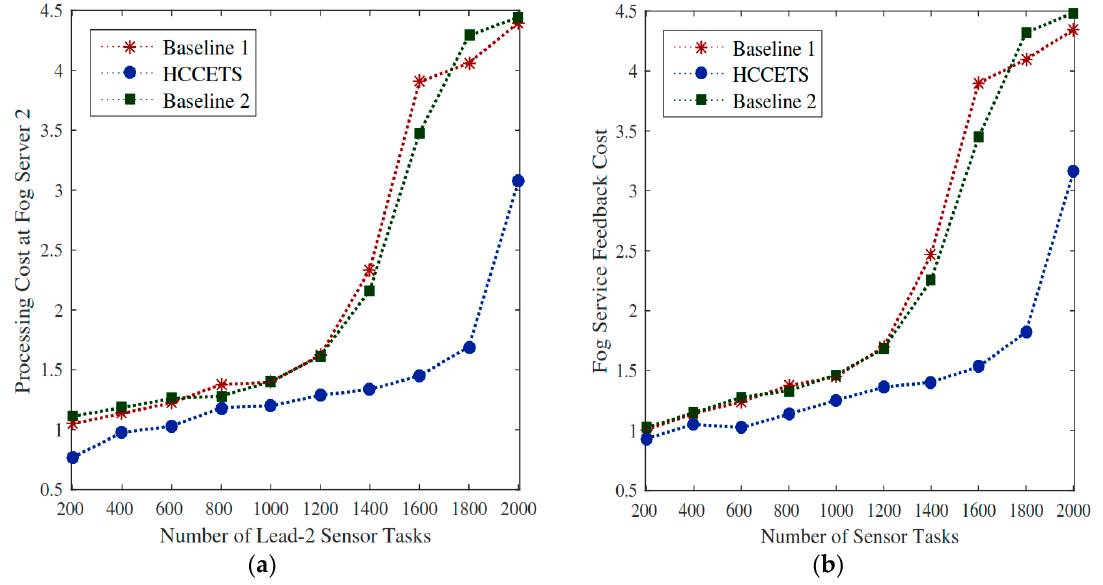
Figure 11. Rescheduling of tasks to fog servers. ( a , b ) the HCCETS incurs lower RPD% as compared